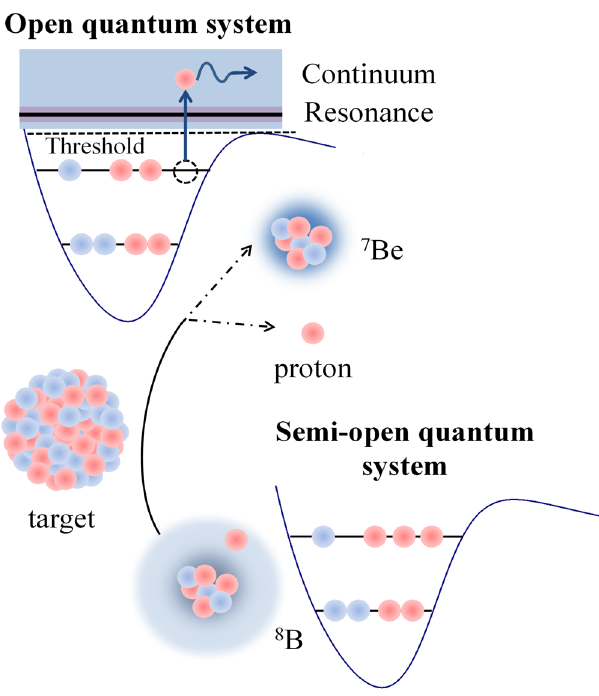
Fig. 1 | Illustration of 8 B breaking up into 7 Be and proton. In the initial state, the nucleons in 8 B occupy bound single particle orbits in the potential well. Although located in the potential well, the halo proton is extremely weakly-bound in an extended distribution around the centrum 7 Be core. It hence can be regarded as a semi-open quantum system. During the collision, 8 B is excited to the unbound states above the breakup threshold (either resonant or non-resonant), forming an open quantum